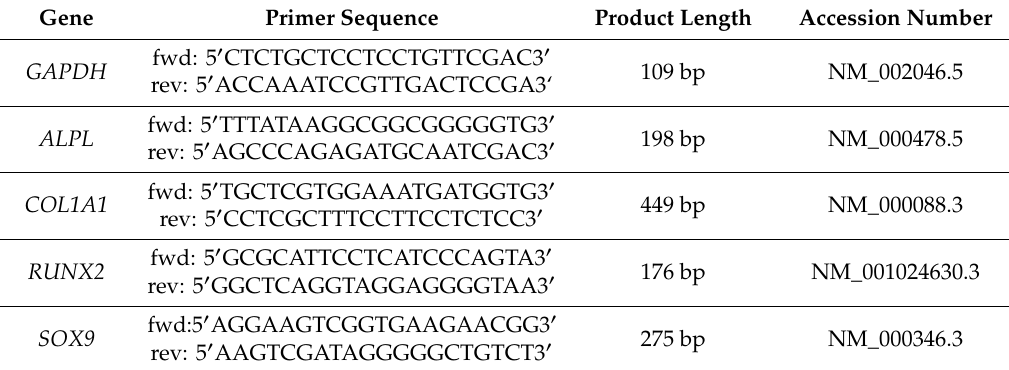
Table 1. Real-Time Polymerase Chain Reaction (RT-PCR). Accession numbers, size of the products, and primer sequences used for determining the relative gene expression of ALPL , COL1A1 , RUNX2, and SOX9 in mesenchymal stromal cells (MSCs) during osteogenic di ff erentiation.